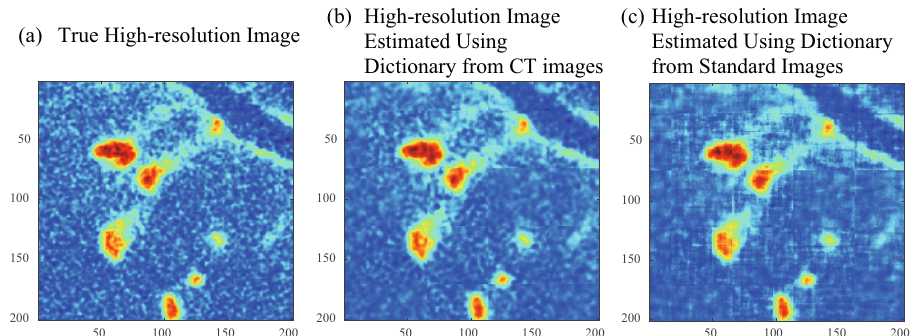
Figure 8. Comparison of high-resolution CT images estimated by using different dictionaries. ( a ) True high- resolution image , ( b ) high-resolution images estimated using dictionaries based on CT images (PSNR: 30.12, SSIM: 0.72), ( c ): high-resolution images estimated using dictionaries based on standard images (PSNR: 27.32, SSIM: 0.57). Voxel size of the high-resolution image was 10 µ m .